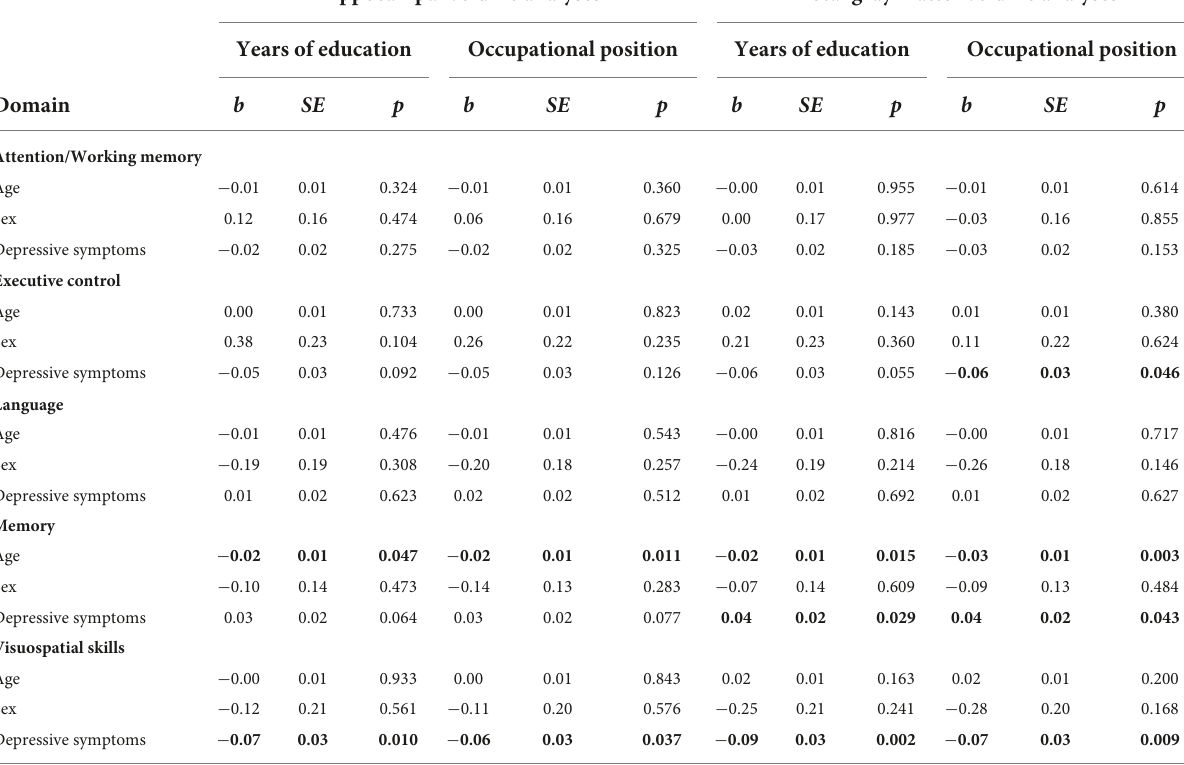
TABLE 5 Covariate effects from moderation analyses for participants with dementia. Hippocampal volume analyses Total gray matter volume analyses Years of education Occupational position Years of education Occupational